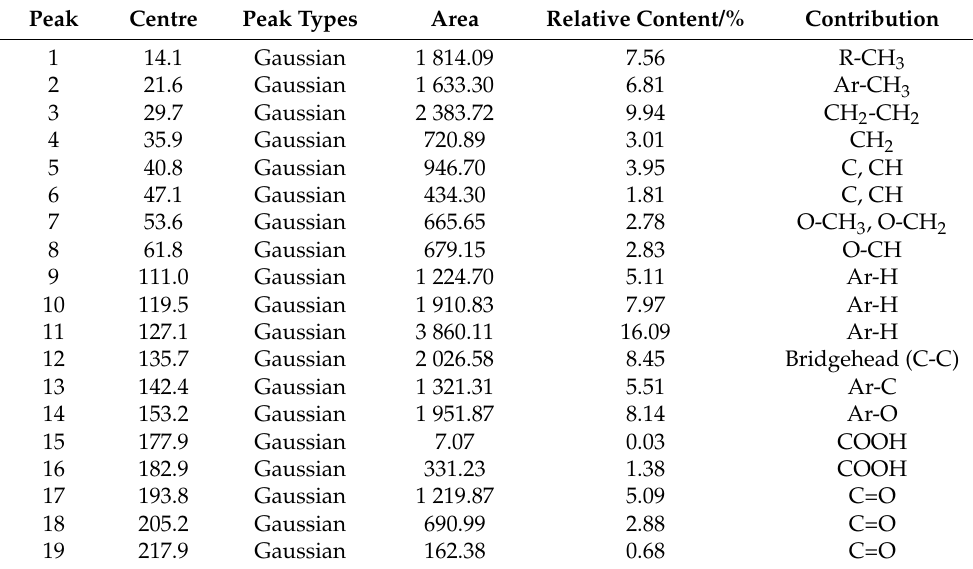
Table 2. Curve-fitted 13 C-NMR of Kerjian coal.